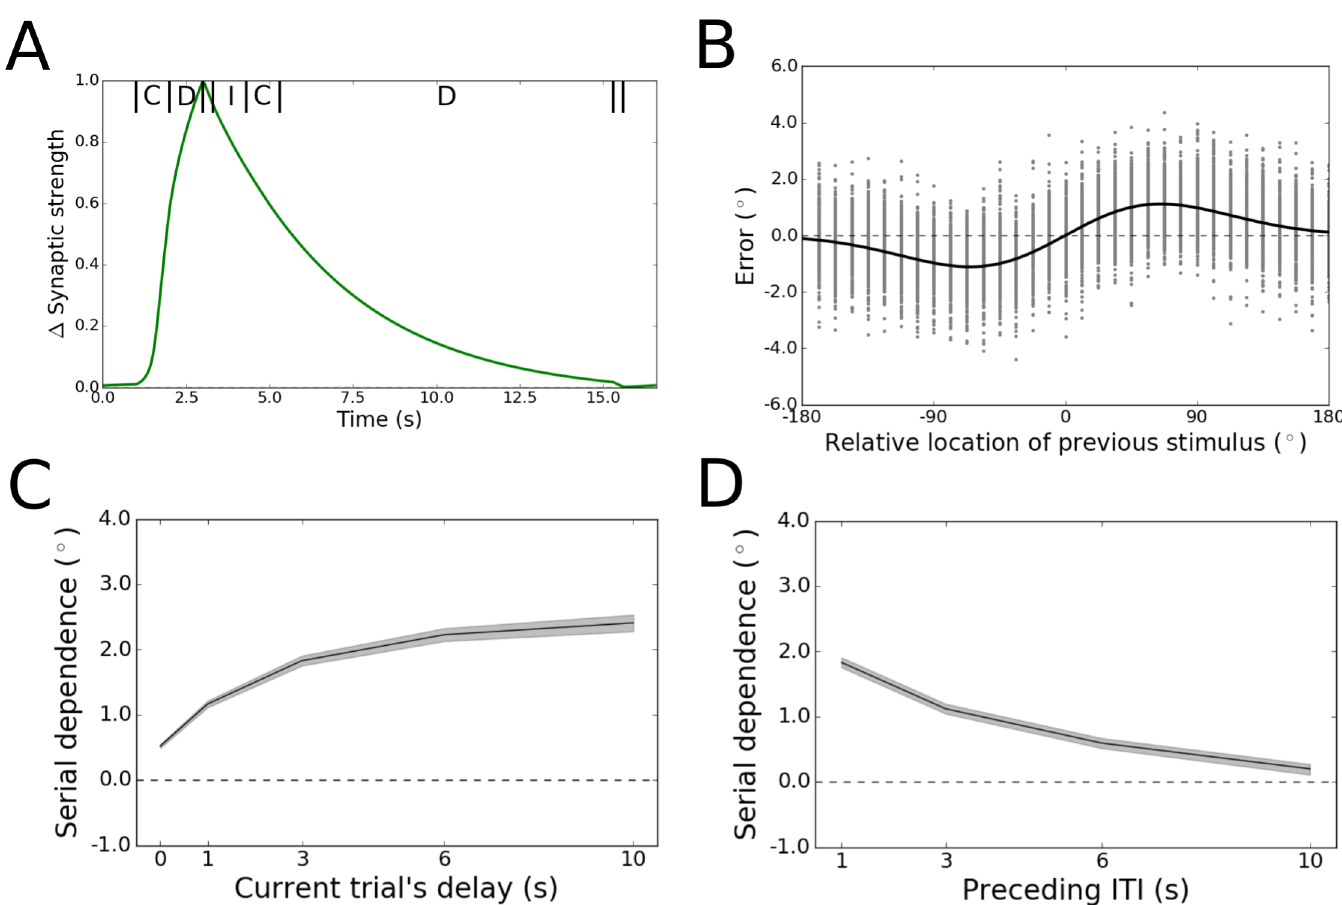
Fig 3. Initial results for Model 3. (A) Normalizedmean change in synapticstrength (relative to the pre-stimulusbaseline)for efferent connections from a sample neuronwith preferredangle 213.75˚. Average results for a single pair of trials are displayed. For this trial pair, the first stimulus was presented at 180˚ and the second at 112.5˚. Synaptic augmentation causes the connectionstrengths to increaseduringthe first trial’s cue (labeledC) and delay (labeledD) periods. During the first reponseperiod, the highlighted neuron’sfiring rate returns to baselinelevels (Fig 1B) and its efferent connectionstrengths slowly return to their originalvalues over the next several seconds, accordingto the time constant of augmentation (4.2 s). The synapticstrength shown is the F parameter of the model, normalized to span the range (0, 1). (B) Tuning of serial dependence across angulardifferences betweenconsecutive stimuli. Raw errors are in gray, and the best fit of the DoG function is in black. Serial dependencewith an amplitudeconsistent with that observedin humans is apparent. (C) Peak-to-peak of the DoG fit across the workingmemory delay. Shadingrepresentsbootstrapped95% confidenceintervals. Serial dependence increases graduallyover time before reachingan asymptote within 10 s. (D) Peak-to-peak of the DoG fit across different ITIs. When the ITI is increasedfrom 1 to 10 s, serial dependence becomesmonotonically weaker.